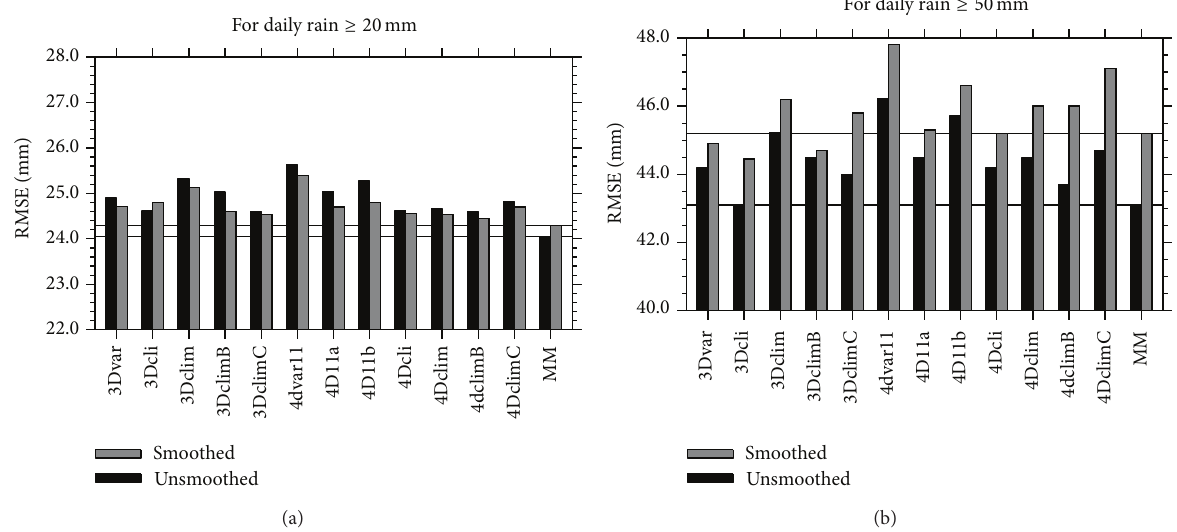
Figure 9: The RMSE of simulated (a) mod-heavy rainfall and (b) heavy rainfall for the whole country for smoothed forecasted rainfall (grey bars) using 9-point smooth three times and unsmoothed forecasted rainfall (dark